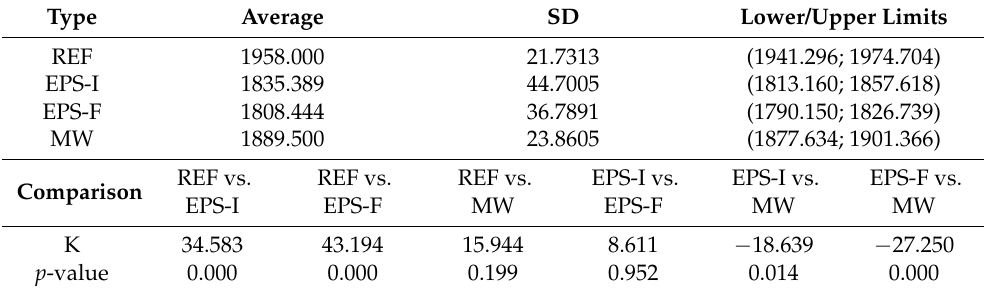
Table 11. Statistical analysis for the density test (kg/m 3 ) for each group of mortar and its comparison.